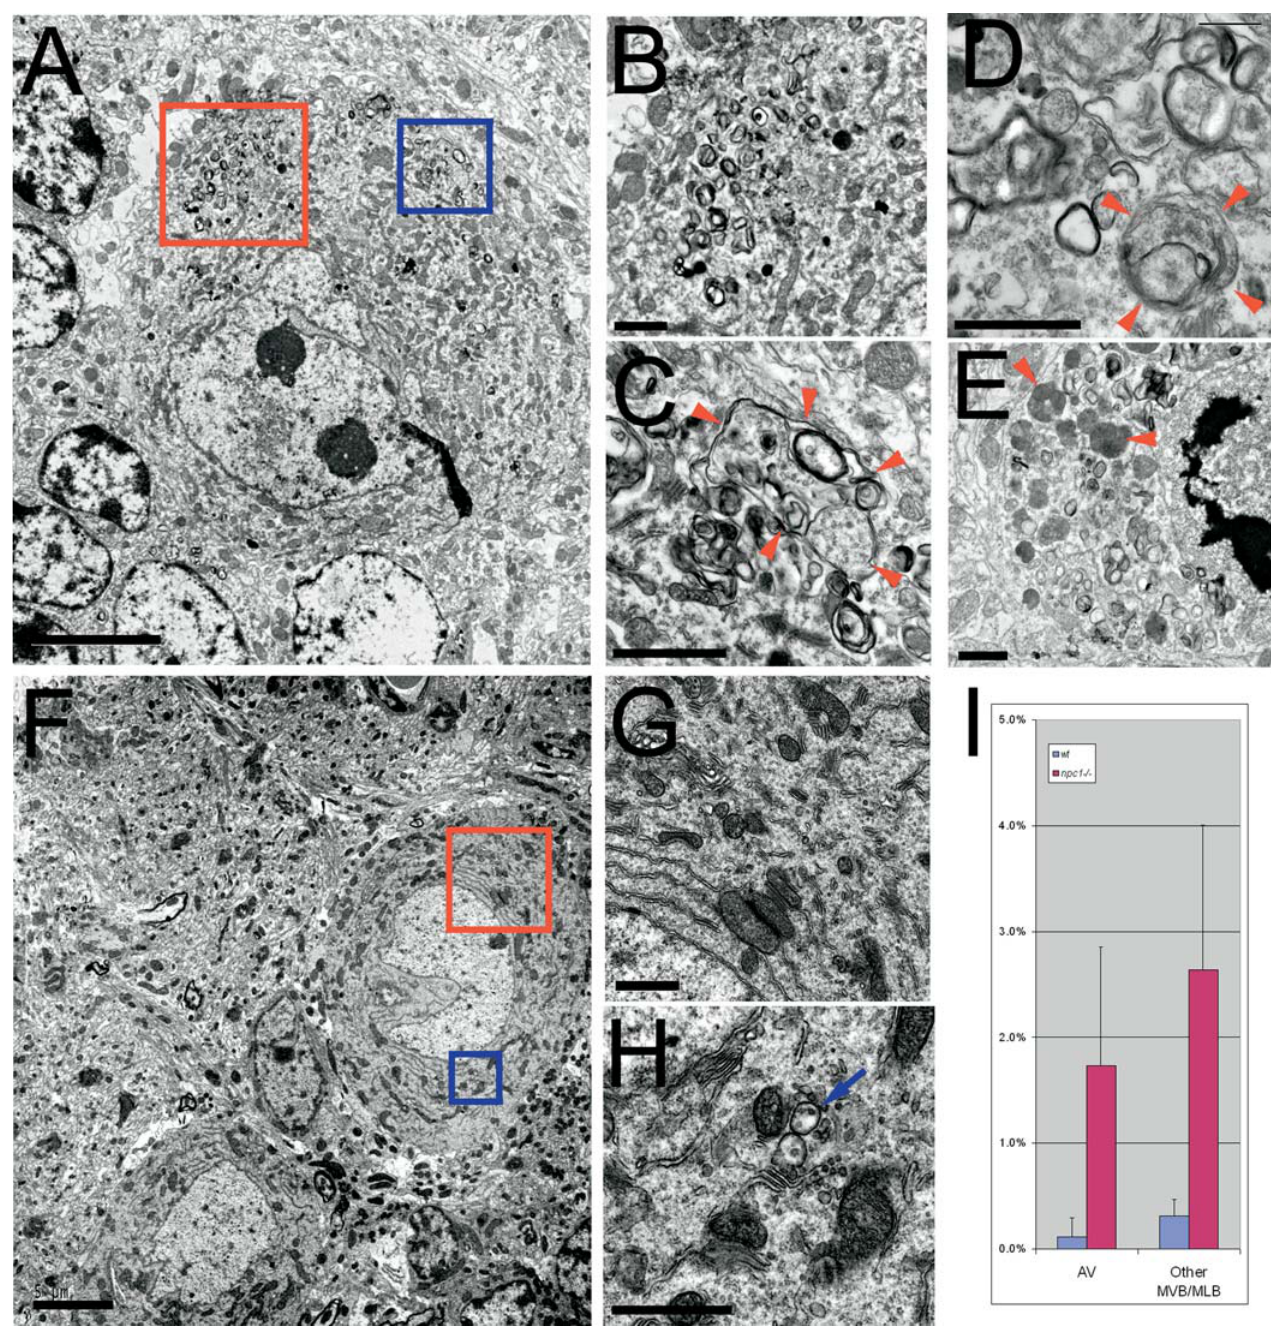
Figure 6. Increased Autophagy in npc1 PCs EM of npc1 (cid:1) / (cid:1) and wild-type PCs from anterior vermis of 48-d-old mice. (A) Low-power field of a typical npc1 PC. (B) Magnification of the red box in (A) showing accumulated multivesicular and multilamellar organelles. (C) Magnification of the blue box in (A) showing a large AV (arrowheads) containing ribosomes and membranes. (D) Another AV (arrowhead) with ER cisternae within the lumen. (E) An npc1 PC probably in the late stages of degeneration, with many AVs, some with apparently degrading mitochondria (arrowheads). (F) Low-power field of two wild-type PCs. (G and H) Magnification of the red (G) and blue (H) boxes in (F) showing no AVs and very few multivesicular organelles (arrow). (I) Quantification of area occupied by AVs and other multivesicular/multilamellar organelles expressed as a percentage of total cytoplasmic area for seven wild-type and seven npc1 (cid:1) / (cid:1) PCs; p ¼ 0.0009 for comparing AV areas and p ¼ 0.0003 for comparing other multivesicular/multilamellar areas, indicating both types of organelles occupy significantly more area in npc1 (cid:1) / (cid:1) PCs. Bar ¼ 5 l m for (A) and (F); for all others, bar ¼ 1 l m. DOI: